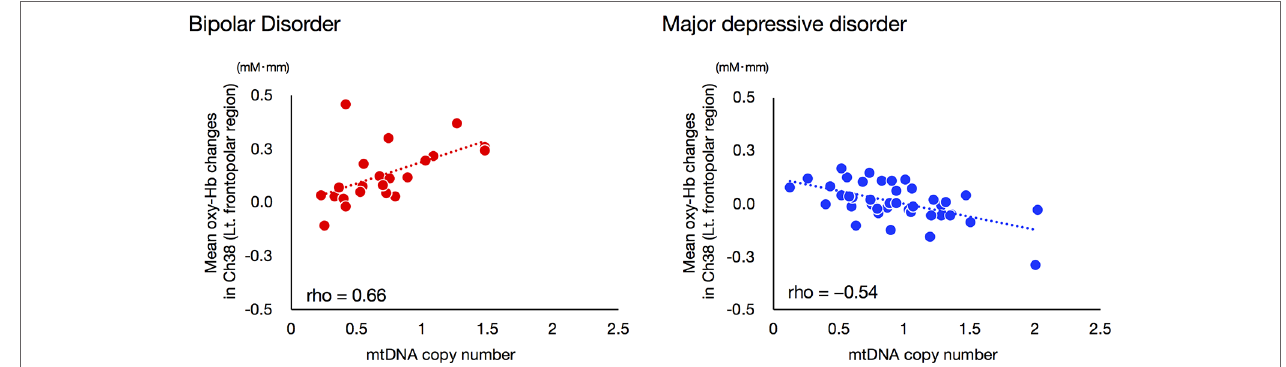
FIGURE 5 | Relationships between mitochondrial DNA copy number and VFT-related oxy-Hb changes in bipolar disorder and major depressive disorder groups. A significant positive correlation between mtDNAcn and mean VFT-related oxy-Hb changes was found for the BD group, while a negative correlation was observed for the MDD group. The threshold for statistical significance was set at Bonferroni-corrected P <